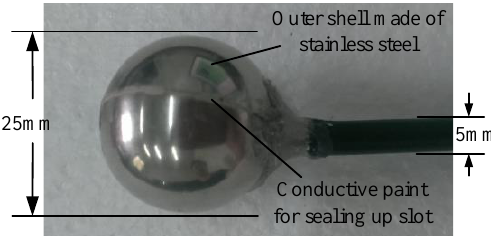
Figure 1. Picture of the double spherical shell sensor.